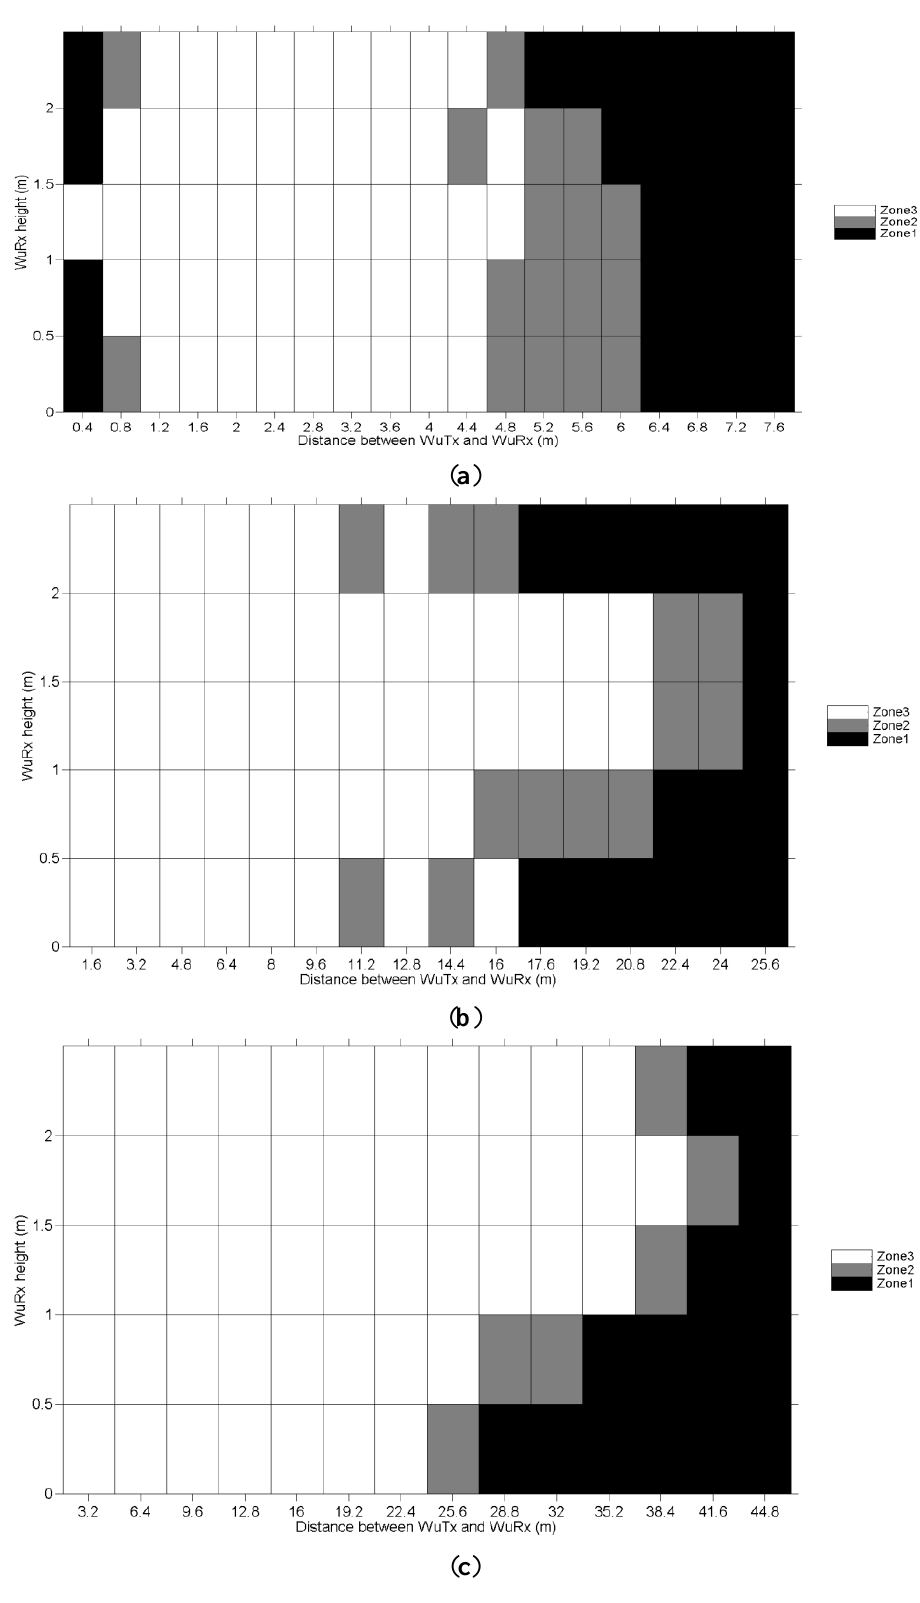
Figure 9. Wake-up distance evaluations for SCM-WuTx output power of ( a ) −10 dBm; ( b ) 0 dBm; and ( c ) +10